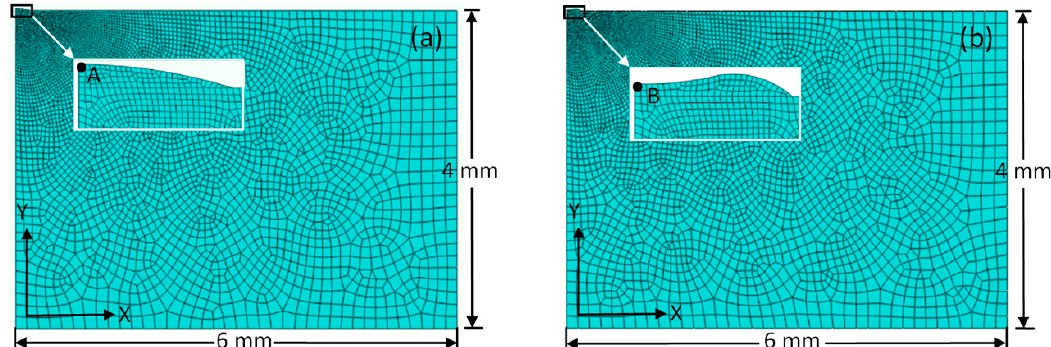
Figure 2. FEM mesh of the model: ( a ) typical thin deposited Layer I (Type I); and( b ) typical thin deposited Layer II (Type II). Table 1. Physical properties of Ti6Al4V alloy.